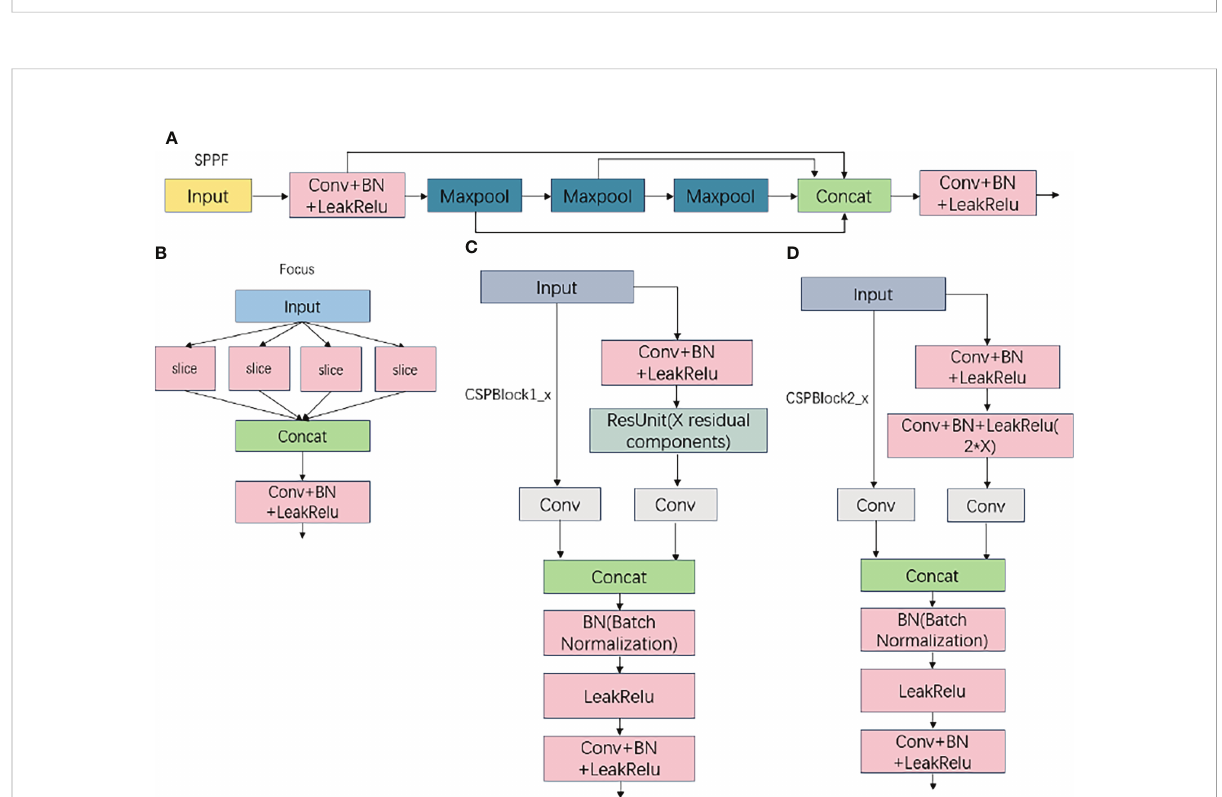
FIGURE 4 Example of darkened Isochrysis sp.